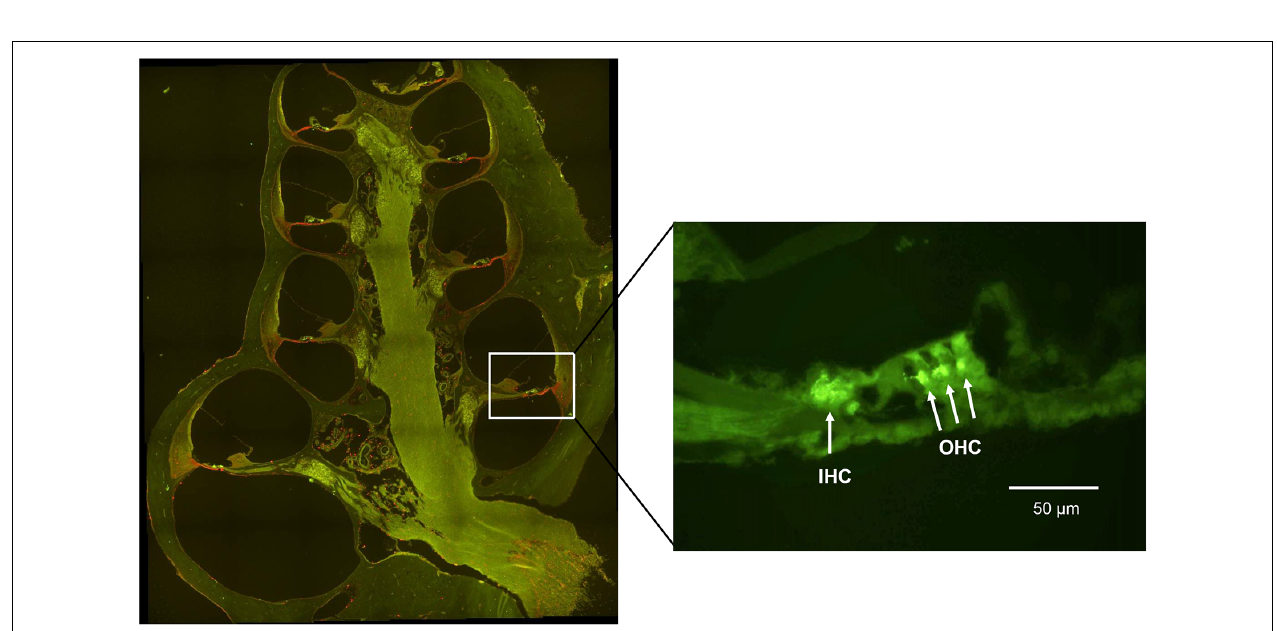
FIGURE 5 | A fluorescent image of a guinea pig cochlea labeled with synaptophysin (green) and Iba1 (red). The enlarged image from the basal turn (7 mm from the RW) shows the synaptophysin immunoreactivity under the IHC and the OHC.